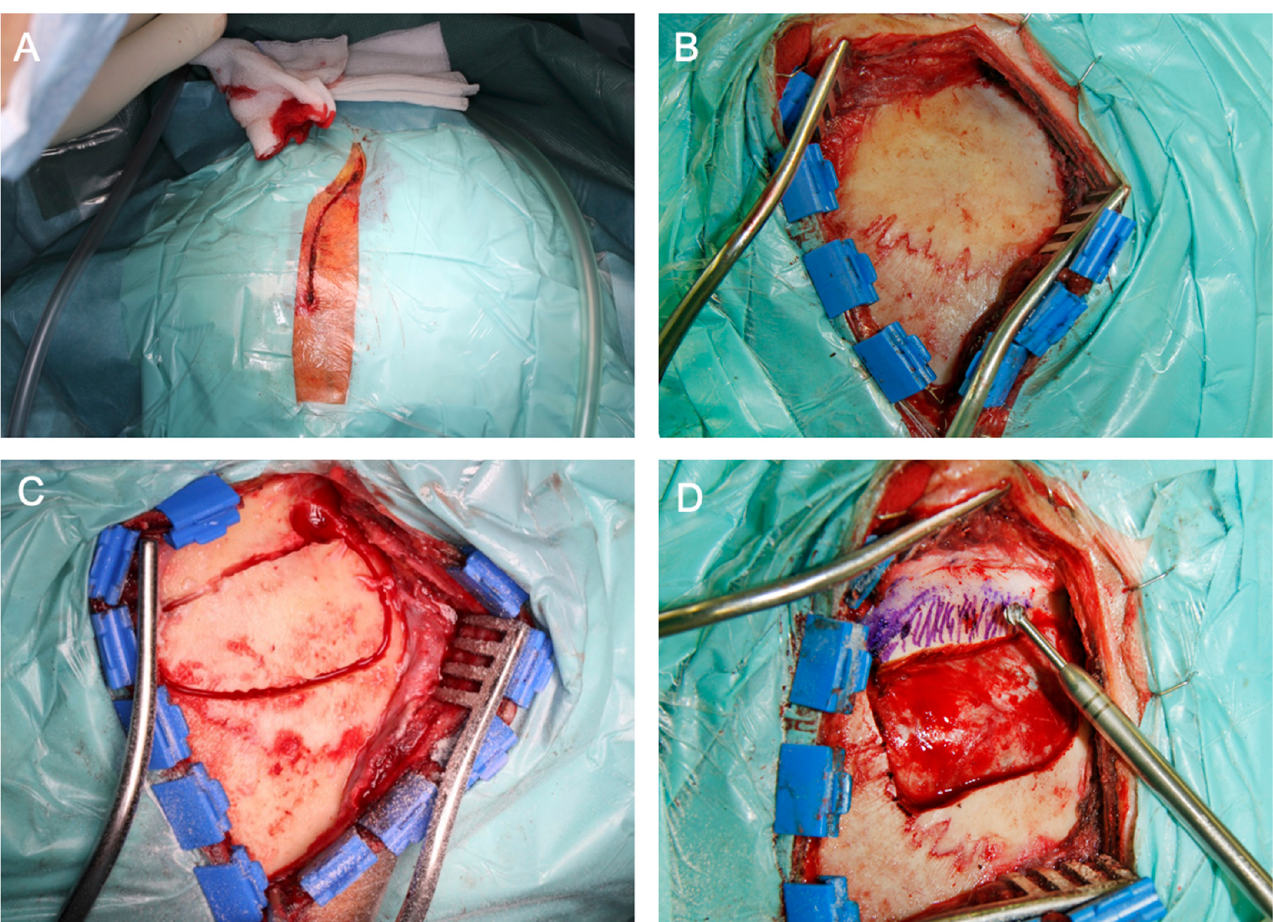
Figure 3. Intraoperative illustration of a subtemporal craniotomy. The patient is placed in a supine position. The head should be rotated as much as possible (~90°) while utilizing a large shoulder roll underneath the ipsilateral shoulder to minimize neck torsion. The head is then tilted ~20° toward the floor for gravity retraction to mobilize the temporal lobe away from the middle fossa. ( A ) A preauricular semi-curvilinear incision is performed, alternatively, a linear incision may be done as well. Large subtemporal lesions benefit from a horseshoe-shaped incision. For lesions that require access to the anterior temporal pole, a small reverse question mark incision would be appropriate, too. ( B , C ) After placing a generous single burr hole just above the root of the zygoma, the dura is mobilized away from the inner table of the calvarium. It is essential to avoid early injury to the dura in order to protect the lobe during extradural subtemporal dissection and later petrosectomy. The craniotomy should be done as close to the middle fossa floor as possible by identifying the upper edge of the root of zygoma which marks the level of the middle fossa floor. The floor is oblique and slopes slightly superiorly from the anterior to posterior direction; the inferior edge of the craniotomy should be only slightly above the level of the zygoma. ( D ) The inferior border often leaves a strip of overhanging bone, obscuring a clear operative trajectory toward the middle fossa floor. Subsequently, a rongeur or a handheld drill may be used to remove this overhanging bone until the edge of the craniotomy is at the level of the floor. The temporal bone and mastoid air cells are waxed to prevent development of a postoperative cerebrospinal fluid fistula.